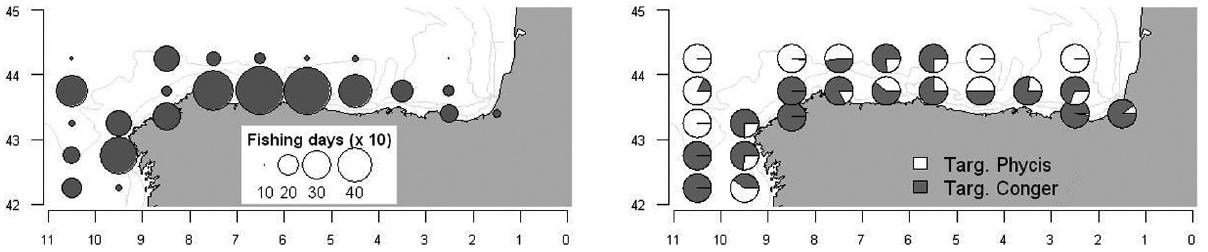
Fig . 6. – Spatial distribution of effort (left) and relative importance by fishing tactic and ICES rectangle from longline in ICES Divisions IXa North and VIIIc